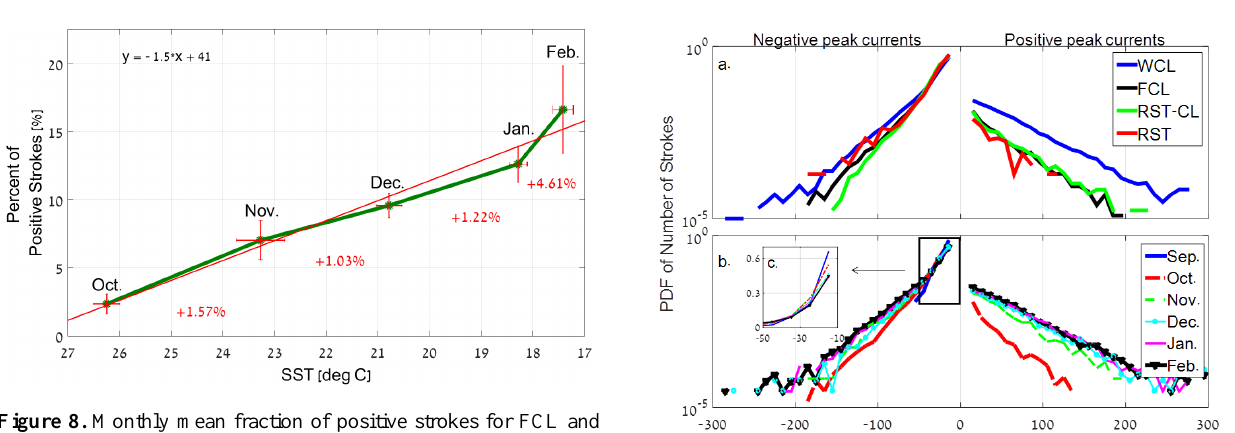
Figure 8. Monthly mean fraction of positive strokes for FCL and WCL systems, between October and February, as a function of the monthly mean SST (green). Note the reverse x axis. Error bars (red) indicate the interannual variations of the two variables. Linear fit is plotted in red. The relative increases in the percent of positive strokes in respect to decrease in the SST are marked by red numbers. SST is calculated based on retrieval from MODIS Aqua, using the 11µm band for the area between 32–36 ◦ E and 30–34 ◦ N.